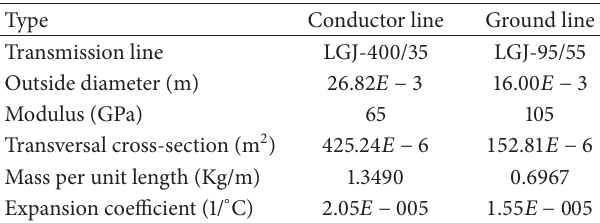
Table 1: Conductor line and ground line